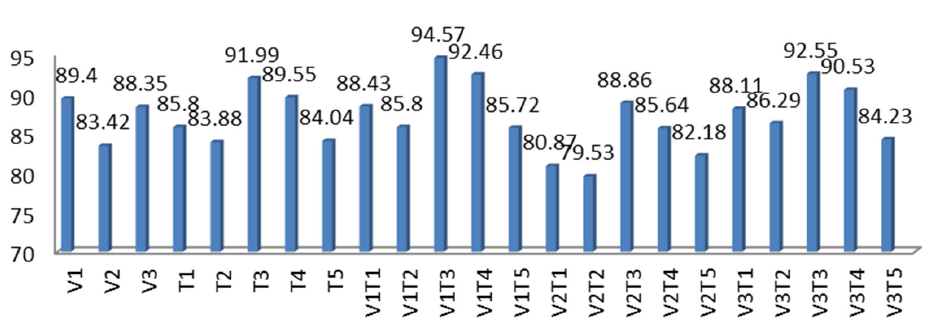
Figure 2. Response of different sweet orange cultivars, time of T-budding and interactions on